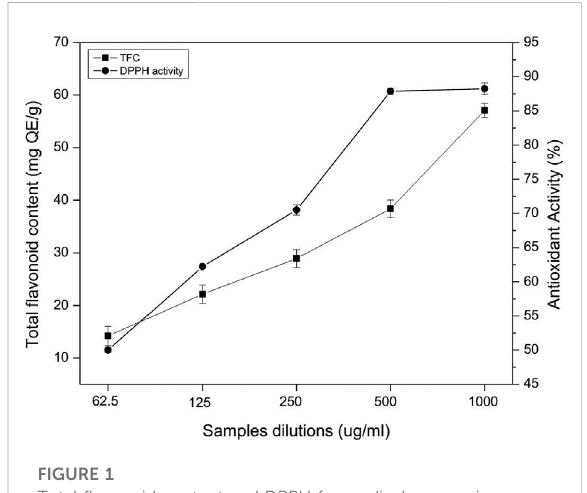
FIGURE 1 Total fl avonoid content and DPPH free radical scavenging capability of P. gemini fl orum .